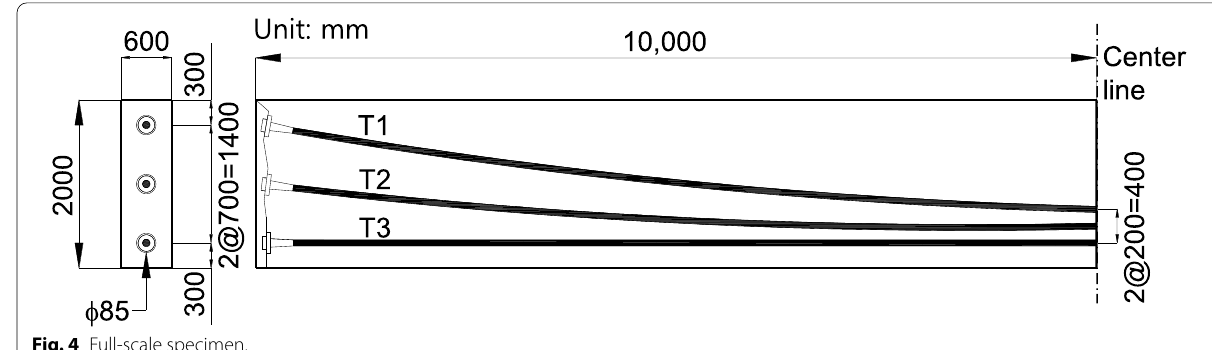
Table 1 Mix proportion of full‑scale specimen.